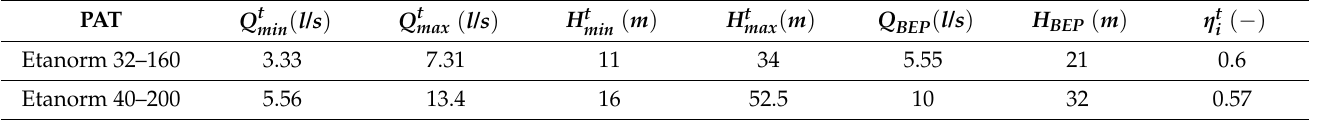
Table 1. Selected PAT